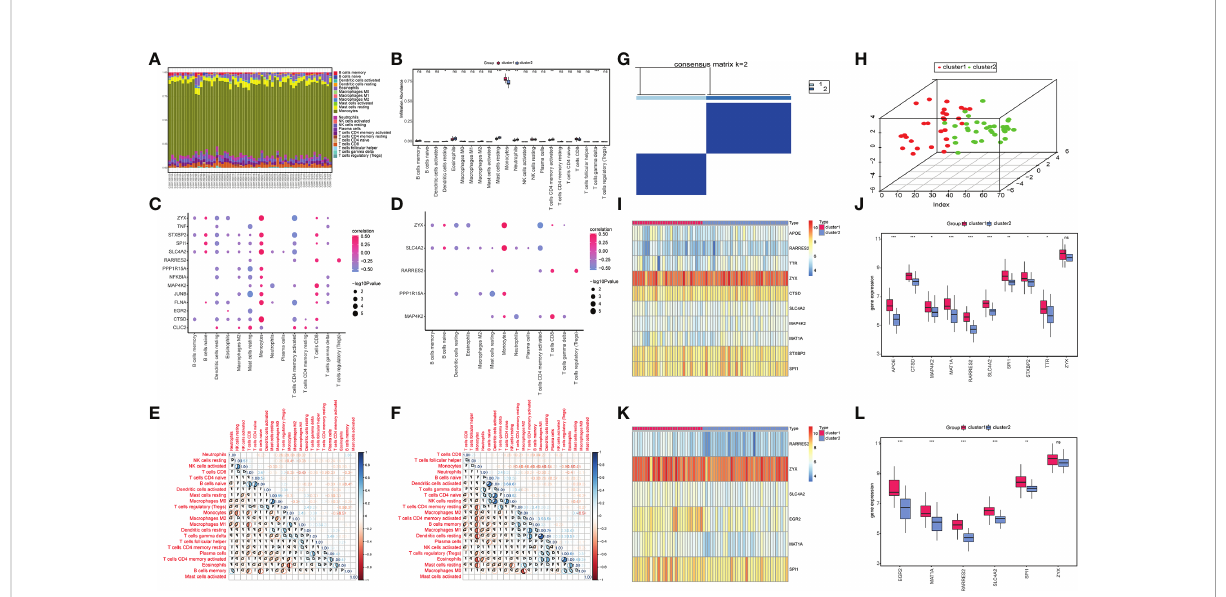
FIGURE 7 Immune in fi ltration analysis and molecular subtype construction based on key OP-related diagnostic marker genes. (A) The accumulation of immune cells between cluster 1 and cluster 2, different colors represent different immune cells, and the horizontal axis represents the patient id. (B) Histogram of immune cell content, the horizontal axis represents immune cells, the vertical axis represents cell content, red represents cluster 1 samples, and blue represents cluster 2 samples. (C) Correlation diagram between OP differentially expressed genes and immune cells, the horizontal axis represents immune cells, the vertical axis represents genes, the color of nodes represents the size of the correlation, and the size of the nodes represents the level of signi fi cance. (D) Correlation diagram between key genes and immune cells, the horizontal axis represents immune cells, the vertical axis represents key genes, the color of the nodes represents the size of the correlation, and the size of the nodes represents the level of signi fi cance. (E, F) Correlation of immune cell content in cluster 1 (E) and cluster 2 samples (F) ; red indicates a negative correlation, and blue shows a positive correlation. (G) Graph of Consistent clustering results. (H) PCA analysis of cluster1 and cluster2. (I, J) Heat map (I) and box plot (J) shows the expression of OP-related differentially expressed genes between the two groups. (K, L) Heatmap (K) and boxplot (L) show the expression levels of key genes between the two groups. Red represents cluster1, and blue represents cluster2. (*P < 0.05, **P < 0.01, ***P < 0.001, ns P > 0.05 no signi fi cance vs.